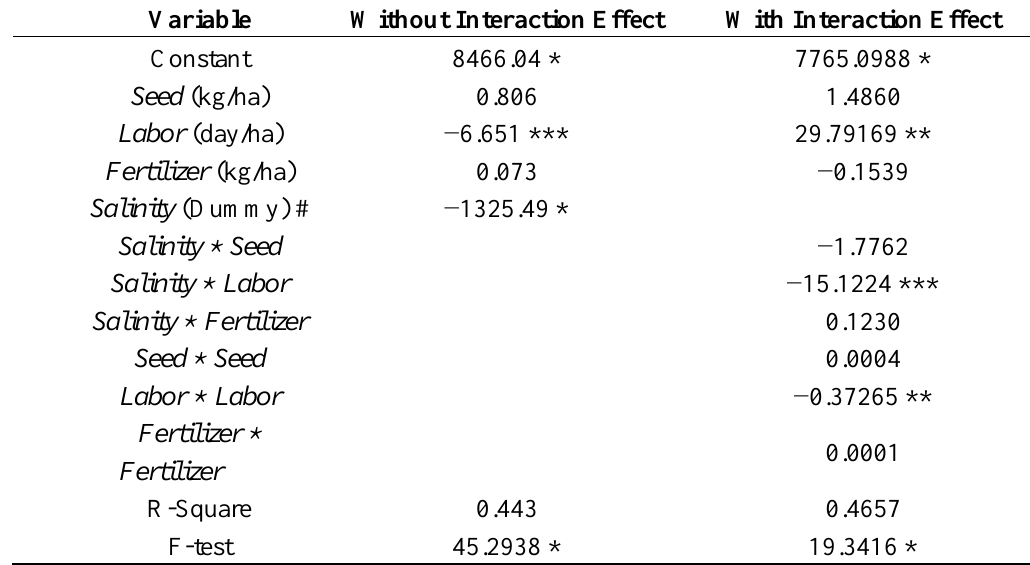
Table A3. OLS estimation of rice production function with salinity impact, dependent variable: yield